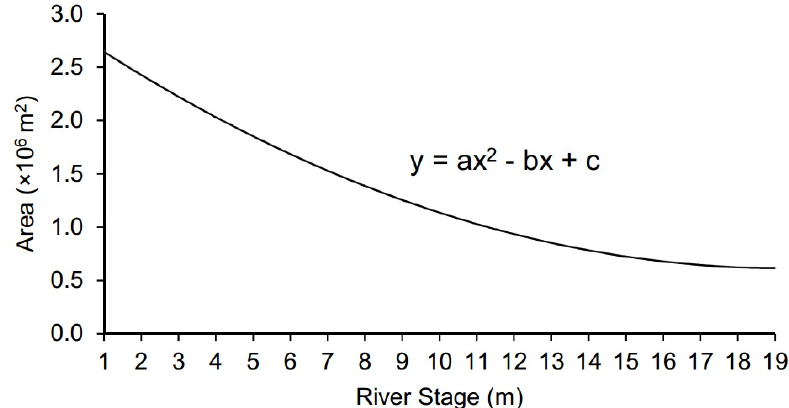
Figure 2. A hypothetical relationship between channel bar surface area and river stage at Tarbert Landing of the lowermost Mississippi